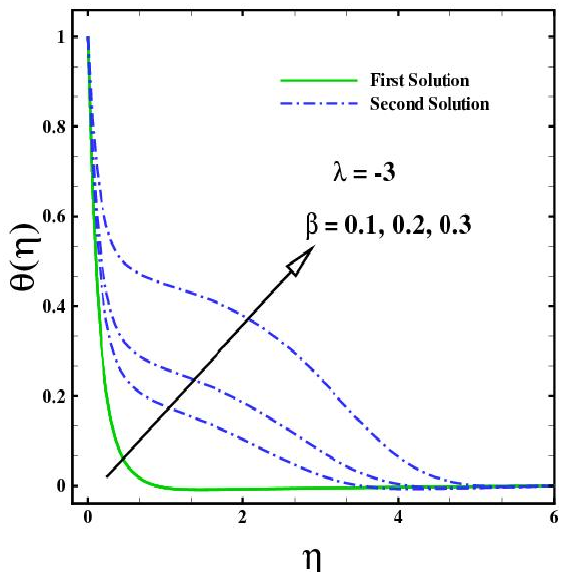
Figure 11. Influence of temperature with different values of β and M = 0.1, We = 0.3, S = 4, Ec = A = B = 0.01, and Pr = n = 2.